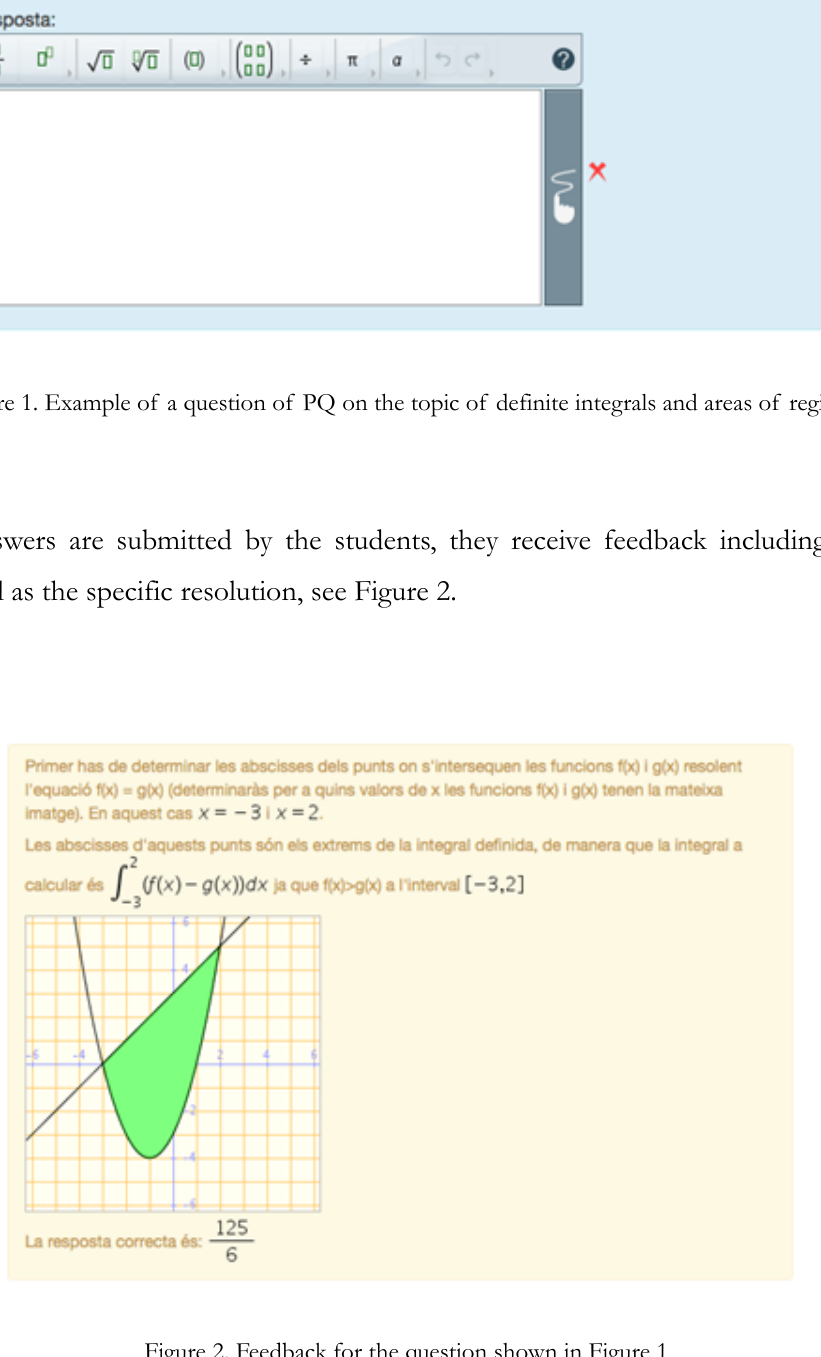
Figure 2. Feedback for the question shown in Figure